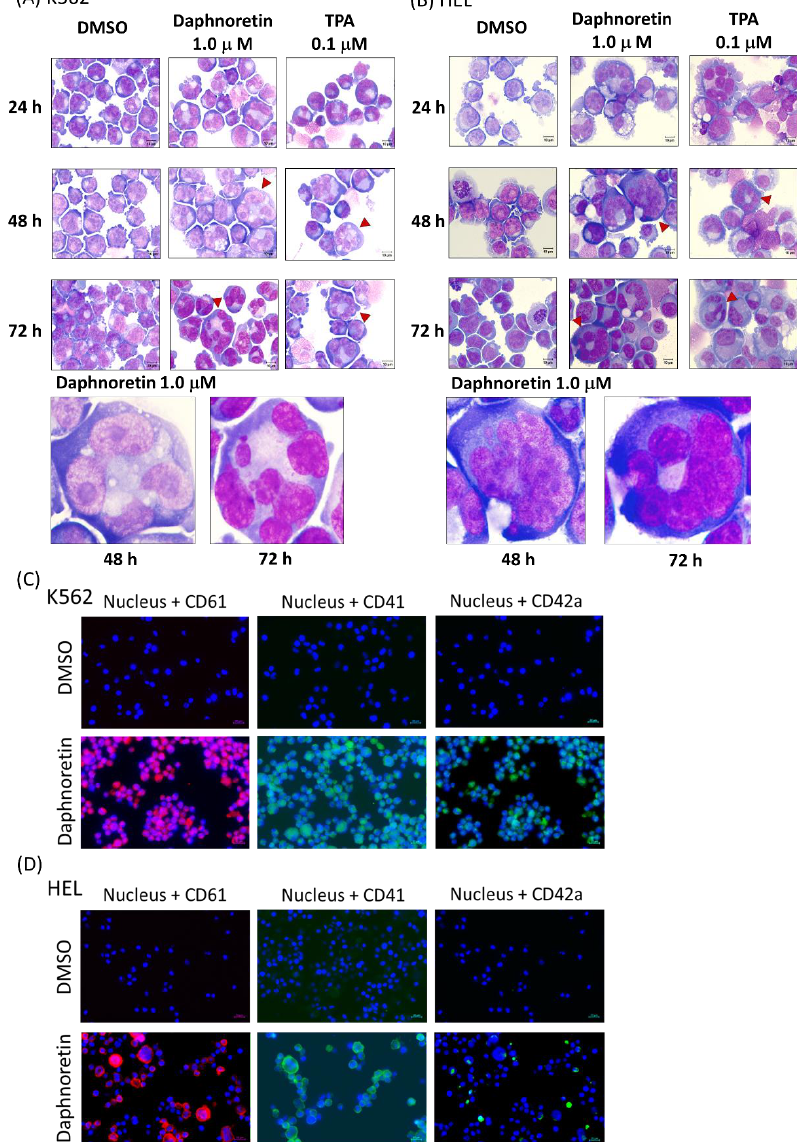
Figure 3. Morphological examination of ( A ) K562 and ( B ) HEL cells treated with 1 µ M daphnoretin or 0.1 µ M TPA for 24–72 h. Cells were stained with Liu’s stain for morphological observation at the original magnification of 1000 × . Scale bars represent 10 µ M, and red arrowhead indicates enlargement of cells with multiple nuclei. Immunofluorescent analysis of ( C ) K562 and ( D ) HEL cells treated with DMSO or 1 µ M daphnoretin for 72 h. Cells were expressed CD61 (red), CD41 (green), and CD42a (green). The nuclei were stained with Hoechst 33,342 (blue). Scale bars represent 20 µ